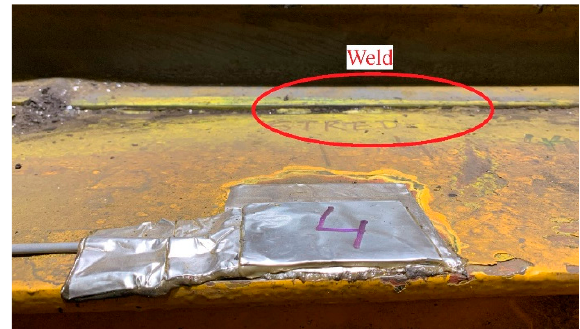
Appl. Sci. 2022 , 12 , x FOR PEER REVIEW